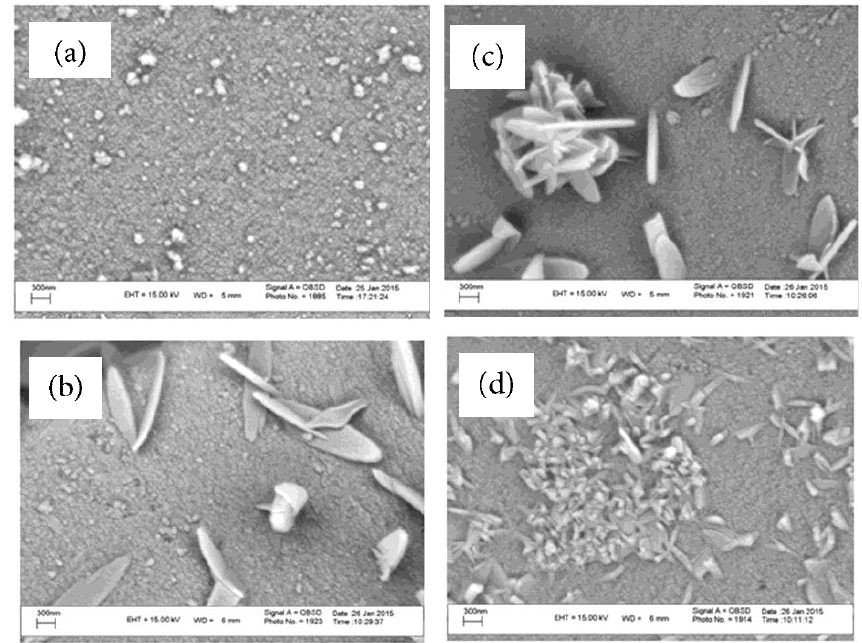
Fig. 3. Typical SEM image of (a) parent silica gel and CuO/SGn produced by immersion times of (b) 40, (c) 60, and (d) 90 min.